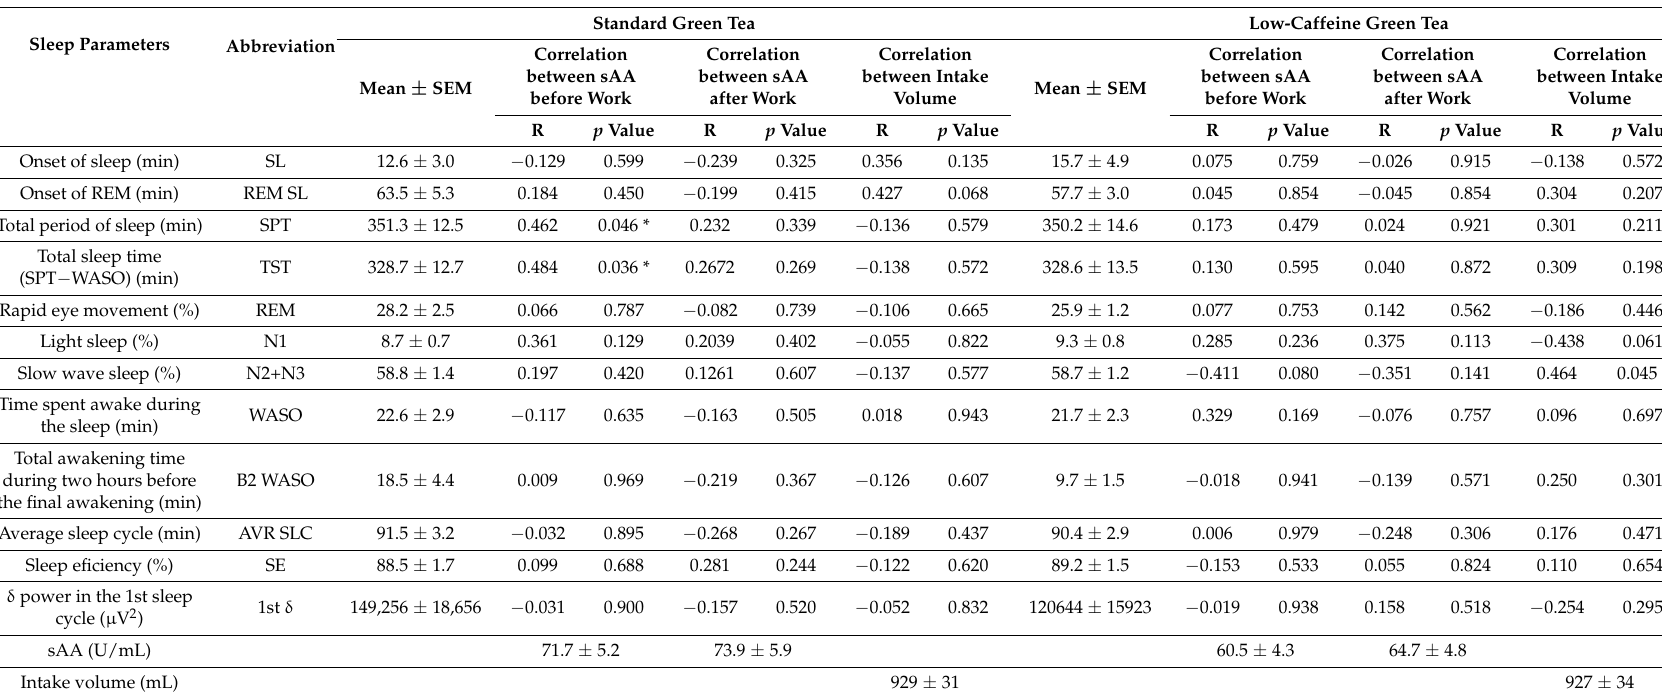
Table 2. Mean value of each sleep parameter and the correlation between sleep parameters and sAA or intake volume when participants drank SGT or LCGT. Sleep Parameters Abbreviation